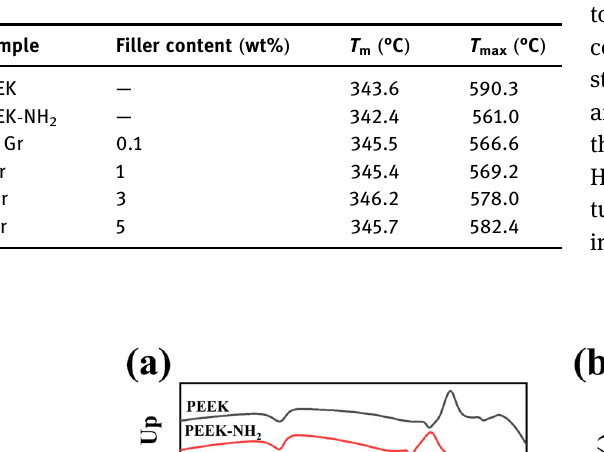
Table 1: Thermal properties of PEEK, PEEK - NH 2 , and PEEK - NH 2 @Gr